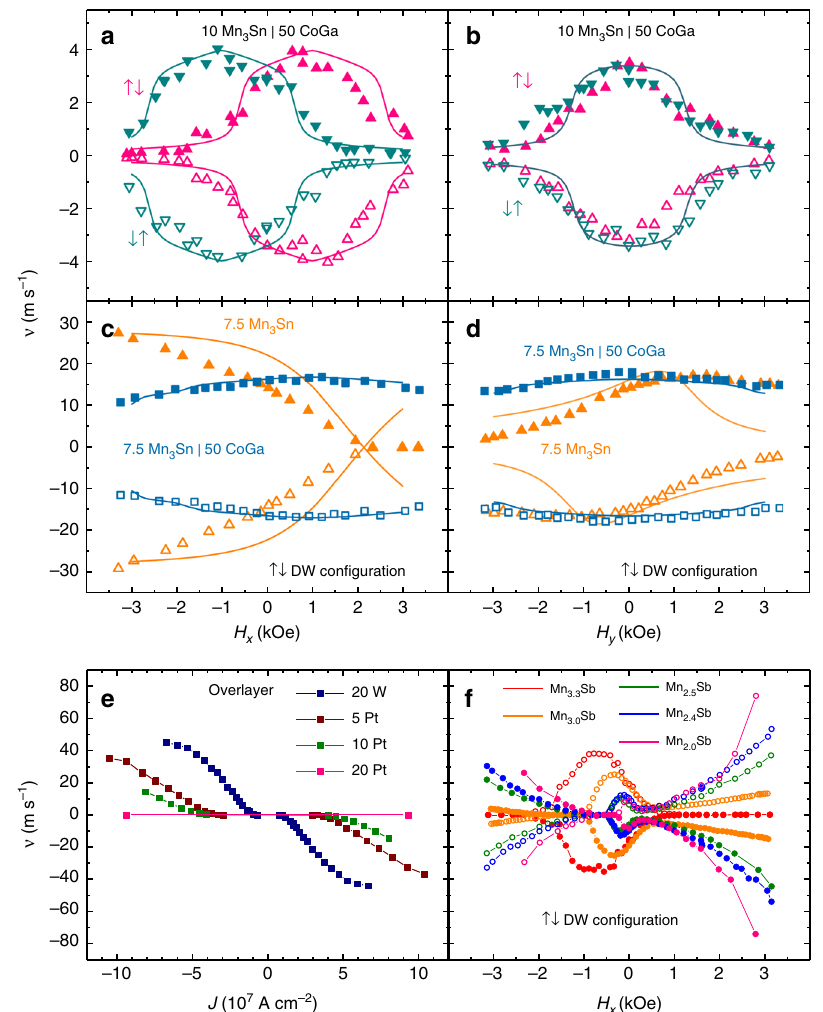
Fig. 5 Spin – orbit torque suppression or enhancement and DMI tailoring. ↑↓ and ↓↑ DW velocity versus in-plane fi eld H x ( a ) and H y ( b ) for a 10 Å Mn 3 Sn Heusler fi lm on CoGa CTL with a 50 Å CoGa overlayer (Fig. 4b and e show corresponding data without a CoGa overlayer). In the H y fi eld dependence, the simulated values for ↑↓ and ↓↑ DW con fi gurations overlap. The fi lm stack is: MgO (001)|20Å MgO|50 Å CoGa|10 Å Mn 3 Sn|50 Å CoGa|20 Å MgO|20 Å Ta and J used for both H x and H y was ~6.8×10 7 Acm − 2 . ( c ), ( d ) ↑↓ DW velocity versus in-plane fi elds, H x and H y , respectively, for 7.5 Å Mn 3 Sn on CoGa CTL, with and without a CoGa overlayer. In the case of no CoGa overlayer, the stack is: MgO (001)|20 Å MgO|50Å CoGa|7.5 Å Mn 3 Sn|20 Å MgO|20 Å Ta and J used for both H x and H y was (cid:3) 5 : 0 ´ 10 7 Acm (cid:2) 2 . With a CoGa overlayer the stack is: MgO (001)|20 Å MgO|50 Å CoGa|7.5 Å Mn 3 Sn|50 Å CoGa|20 Å MgO|20Å Ta and J used for both H x and H y was (cid:3) 5 : 7 ´ 10 7 Acm (cid:2) 2 . Solid lines represent the 1D model simulation. e Overlayer dependence of the DW velocity versus current density for a 20 Å Mn 3 Sb fi lm on a CoGa CTL. The stack is: MgO (001)|20 Å MgO|50 Å CoGa|20 Å Mn 3 Sb|5 Å CoGa|5 – 20 Å Pt or 20 Å W|20 Å MgO|20 Å Ta. f Mn x Sb composition dependence on ↑↓ DW velocity versus in-plane H x fi eld for the stack: MgO (001)|20 Å MgO|50 Å